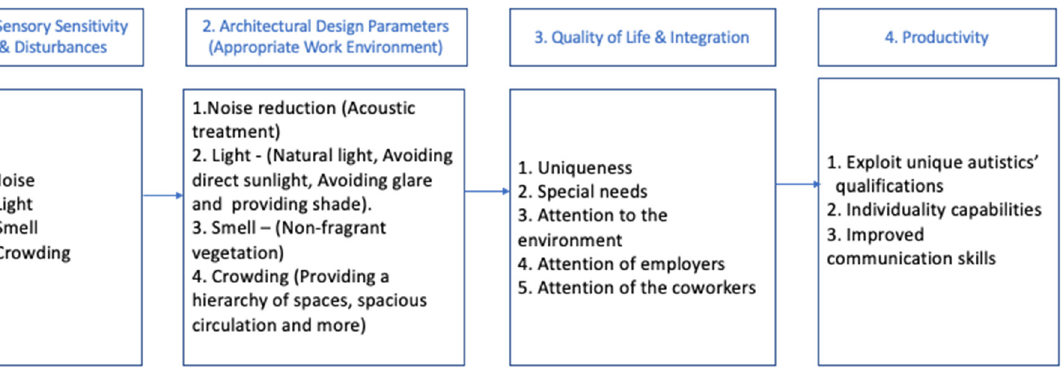
Figure 4. Architectural design topics, requirements, and their contribution to the integration of autistic people in workplaces.